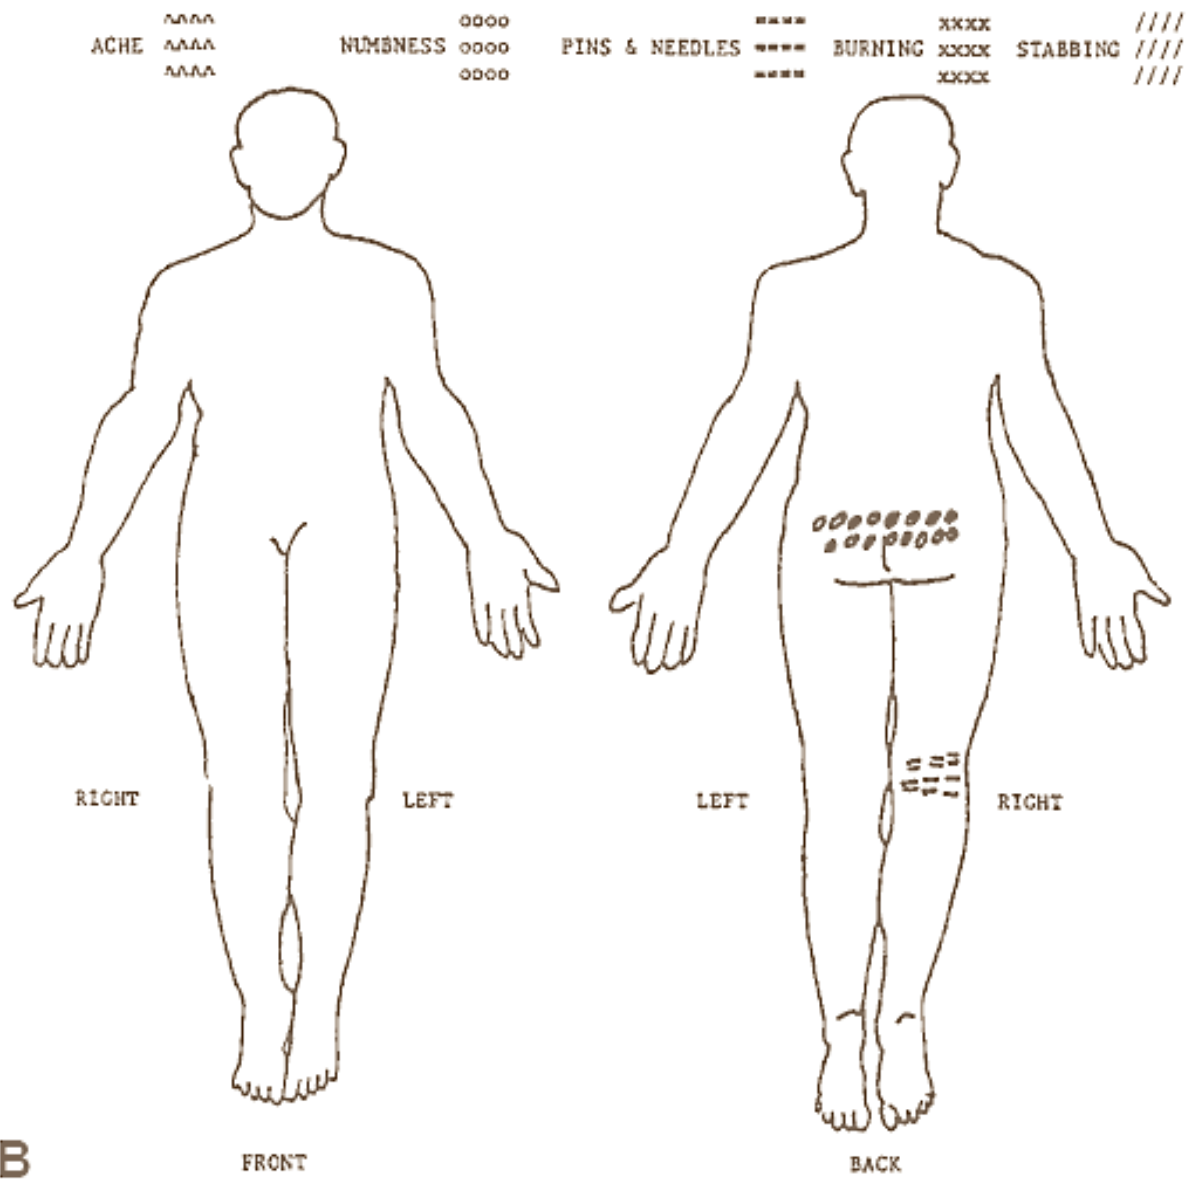
Figure 1. A completed pain drawing